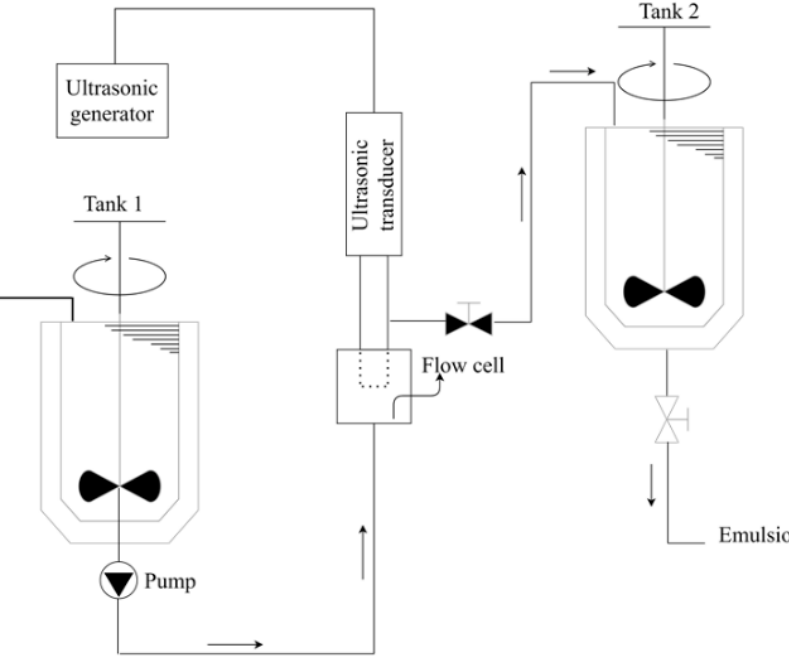
Figure 7. Schematic representation of the continuous emulsification system using